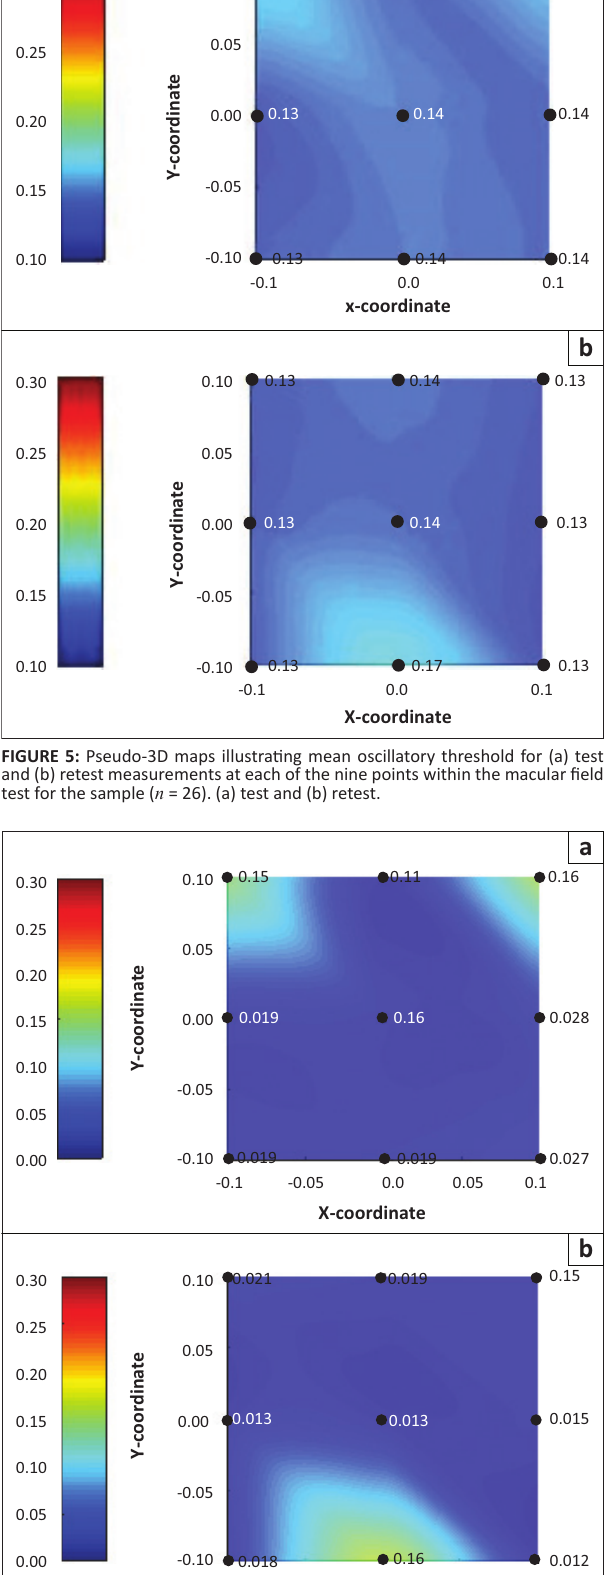
ocular pathologies. Figure 8 indicates the correlation between macular thickness and OT at the fovea (central subfield/foveal thickness and Point 5). There was no relationship between OT and macular thickness ( r = –0.14, p = 0.49 and r = 0.03, p = 0.89 for test and retest samples, respectively).